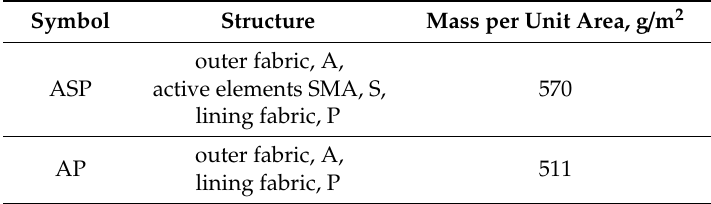
Table 2. Textile materials. A: aluminized woven fabric with para-aramid and oxidized poliacrylonitrile fibers, P: 100% aramid fibers.